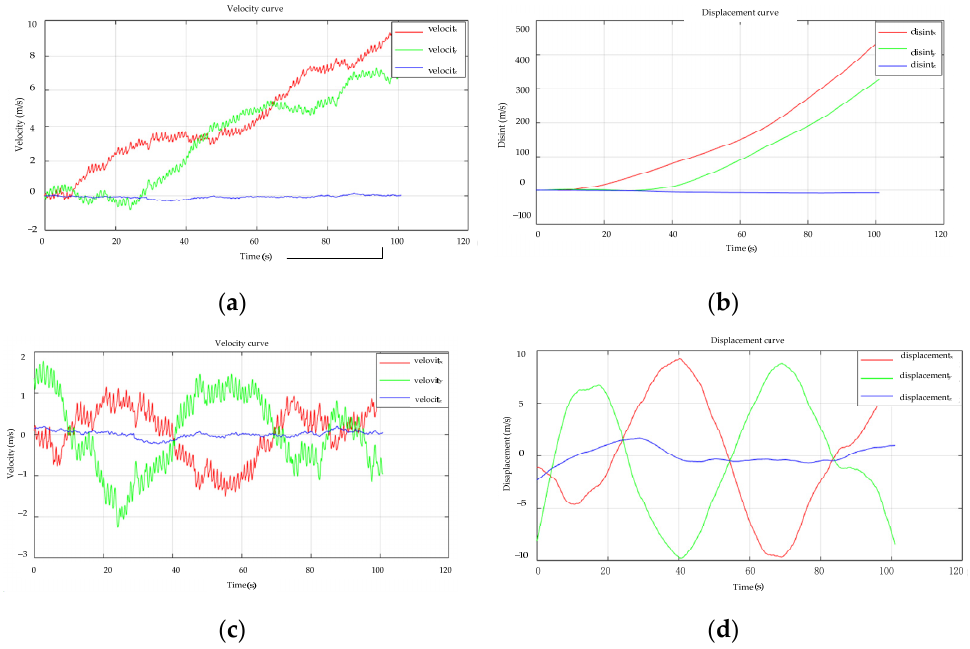
Figure 10. Data curve before and after least-squares method. ( a ) Unprocessed speed curve; ( b ) Dis- placement curve obtained without processing; ( c ) After processing, the speed curve is obtained; ( d ) Displacement curve obtained after processing.